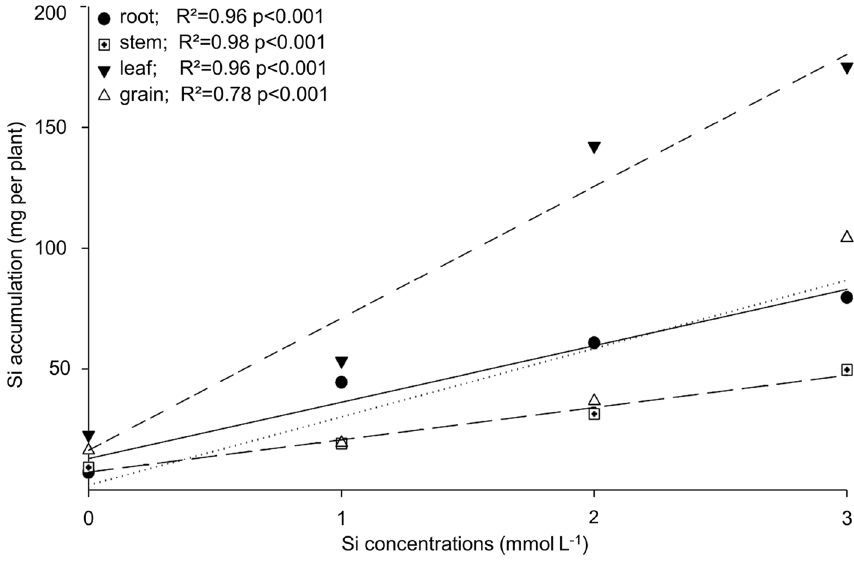
Figure 1. Si accumulation in the root, stem, leaf, and grains of quinoa for the studied Si